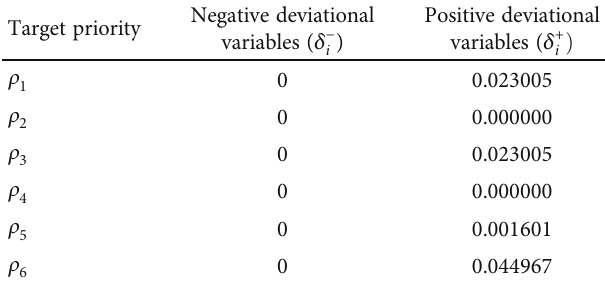
Table 5: Outcomes of deviational